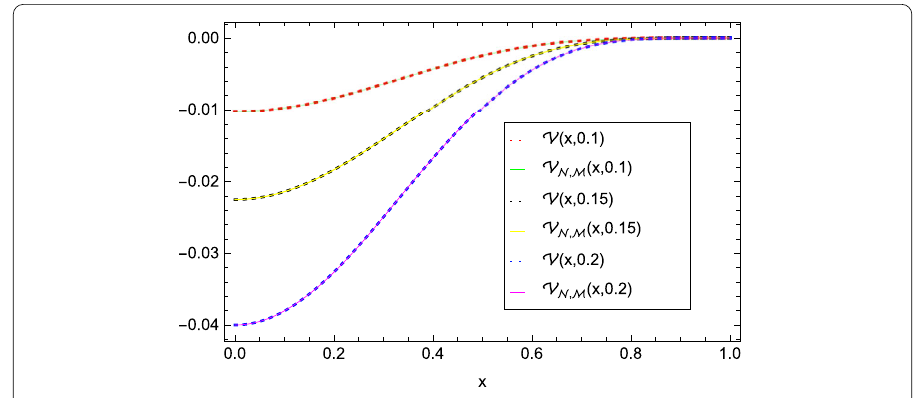
Figure 9 x -direction curves of V and V N , M of problem (3), where δ = 1.8, N = 10, M = 2